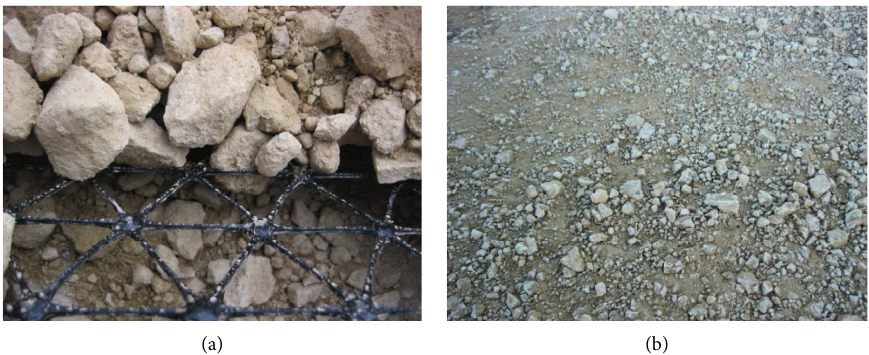
Figure 6: (a) C-stone and geogrid and (b) C-stone unstabilized test sections.